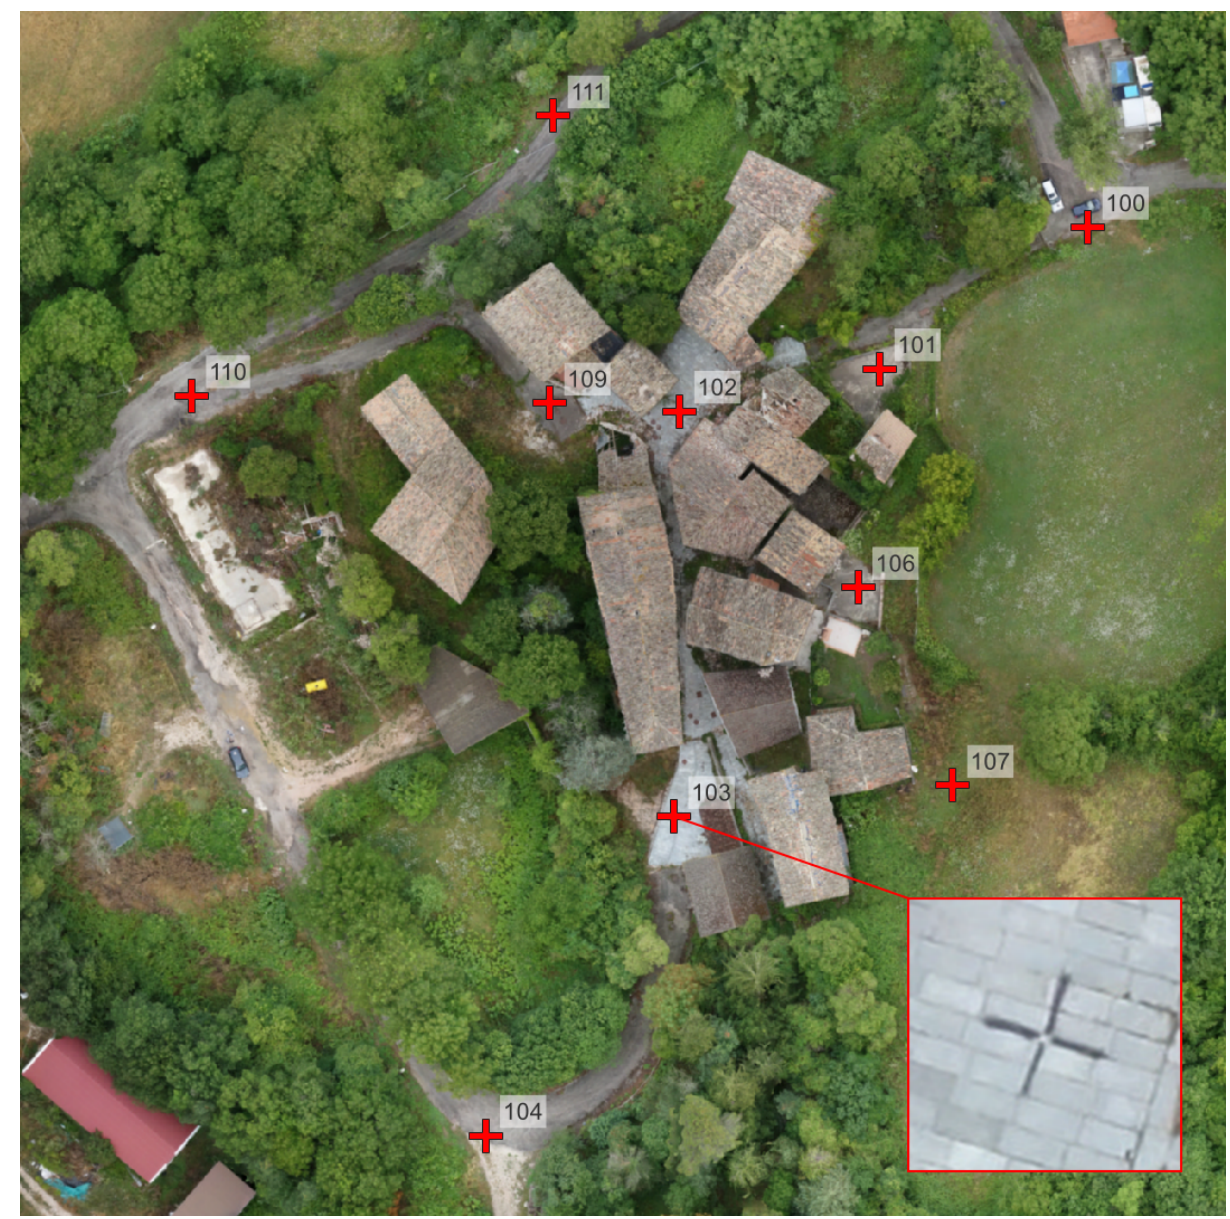
Figure 4. Ground control point